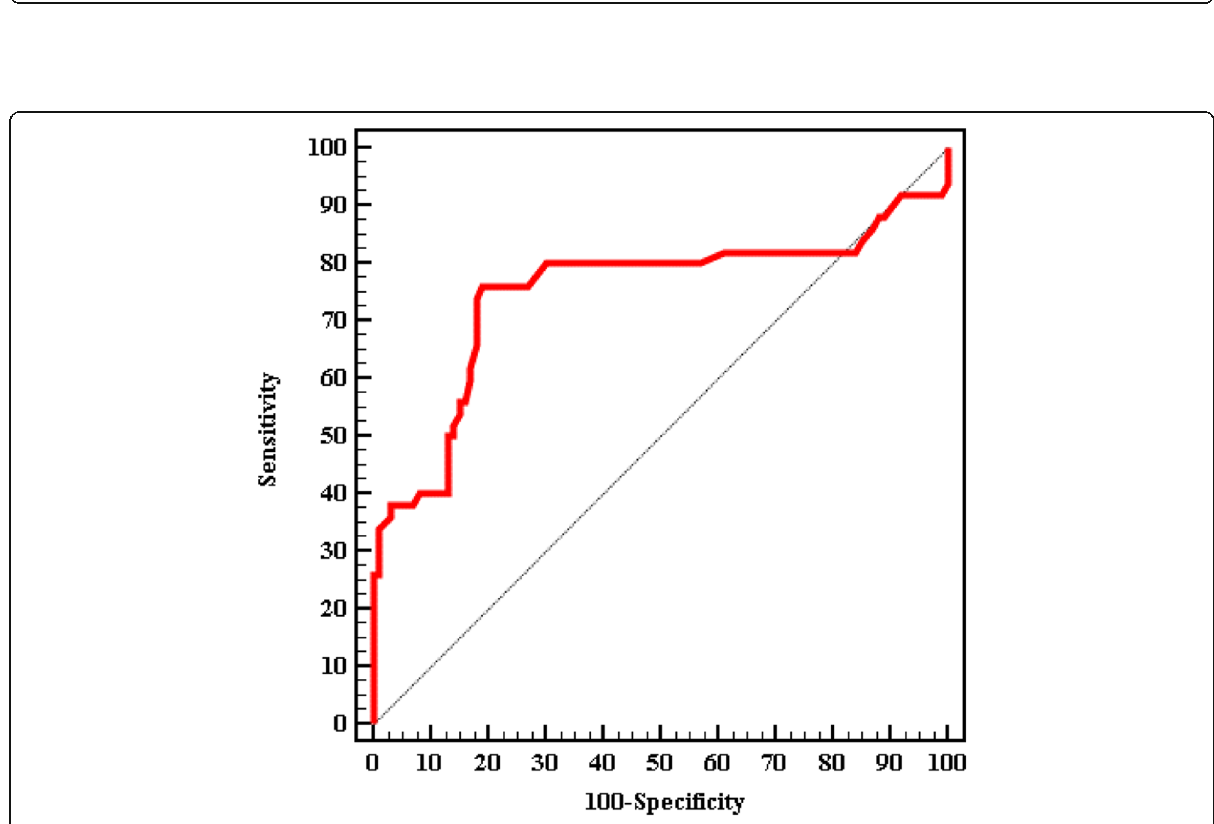
Fig. 2 ROC curve for miR-331-3p to predict Early-stage HCC patients (group II) from HCV-related cirrhosis (group